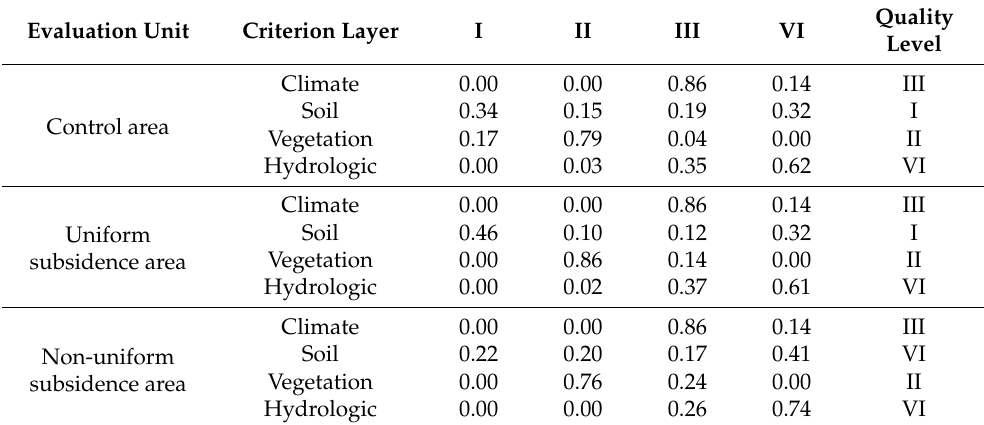
Table 5. The membership value of the ecological evaluation index at the criteria